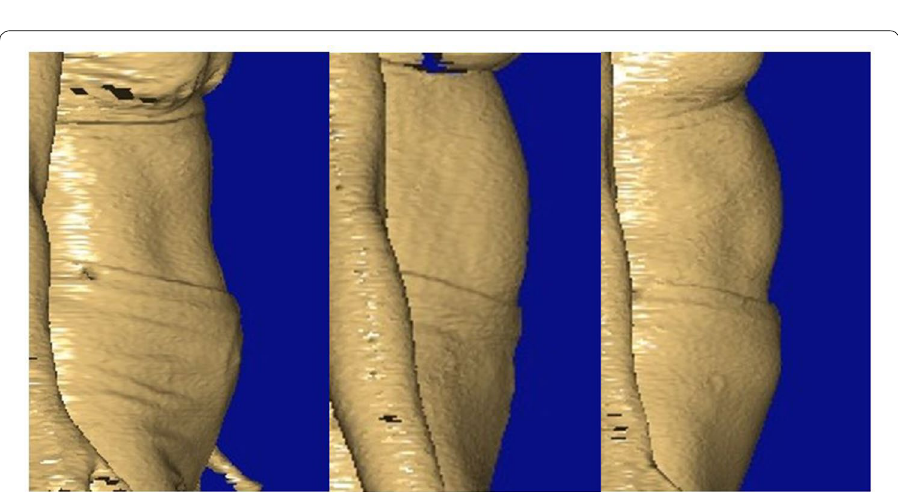
Fig. 11 Examples of the GLBFP identifier, from left: abdomen, stomach, and